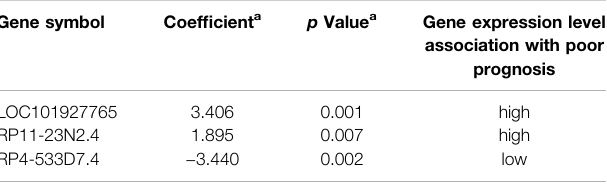
TABLE 2 | Identities of PCG and lncRNAs in the prognostic expression signature and their univariable cox association with prognosis. Gene symbol p Value a Gene expression level association with